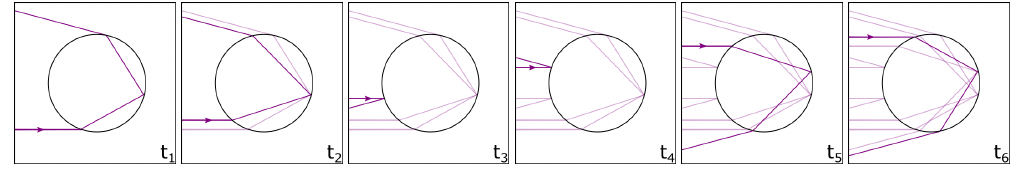
Figure 3. Schematic view of a scattered laser beam exiting a transparent droplet with n = 1.333 at ϑ S = 165 ◦ for different times t 1 to t 6 as a function of droplet velocity v z . The predominant scattering mode at the presented time step is shown as the thick